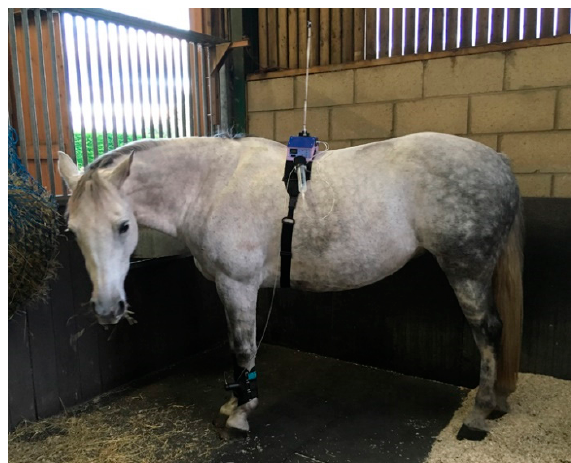
Figure 8. Horse with mechanical system in place: control unit and reservoir mounted on the back, with pressure line to the actuator on the foreleg.